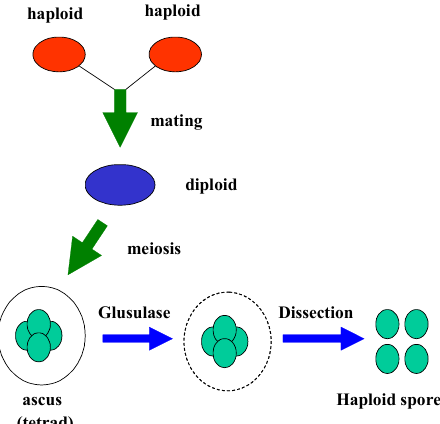
Figure 2. Flow chart outlining the steps involved in meiosis and the production of ascospores in S. cerevisiae . Haploid strains of opposite mating types were mated to produce diploid cells. Diploid cells were then sporulated, and ascal cell walls were treated with the lytic enzyme, glusulase. The treated asci or tetrads were microdissected to release and analyze the four spore products of meiosis.